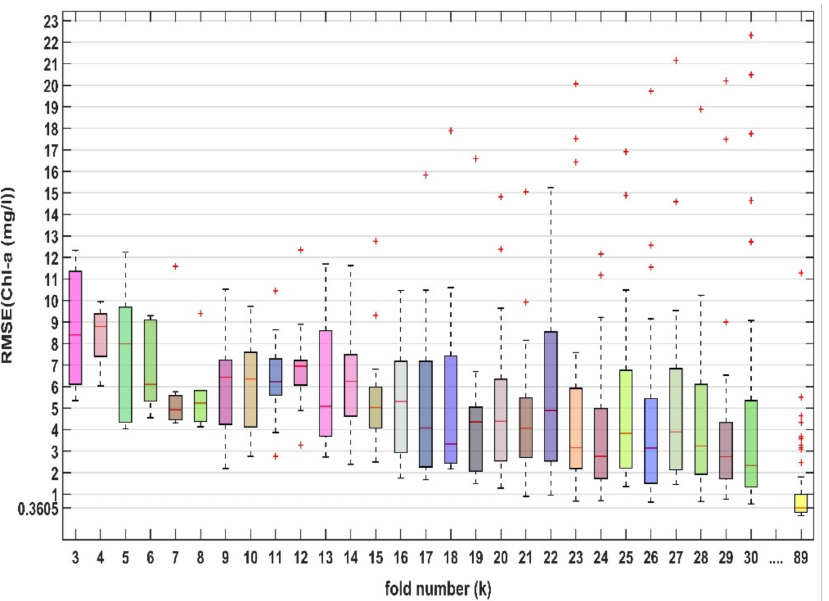
Figure 3. Comparison of the ANN’s Root Mean Square Error (RMSE) performance index for k = 3:30 and k = 89 (leave-one-out case) values. k = 89 achieves the lowest RMSE = 0.3605. Red marks are extreme values referred as “outliers”.